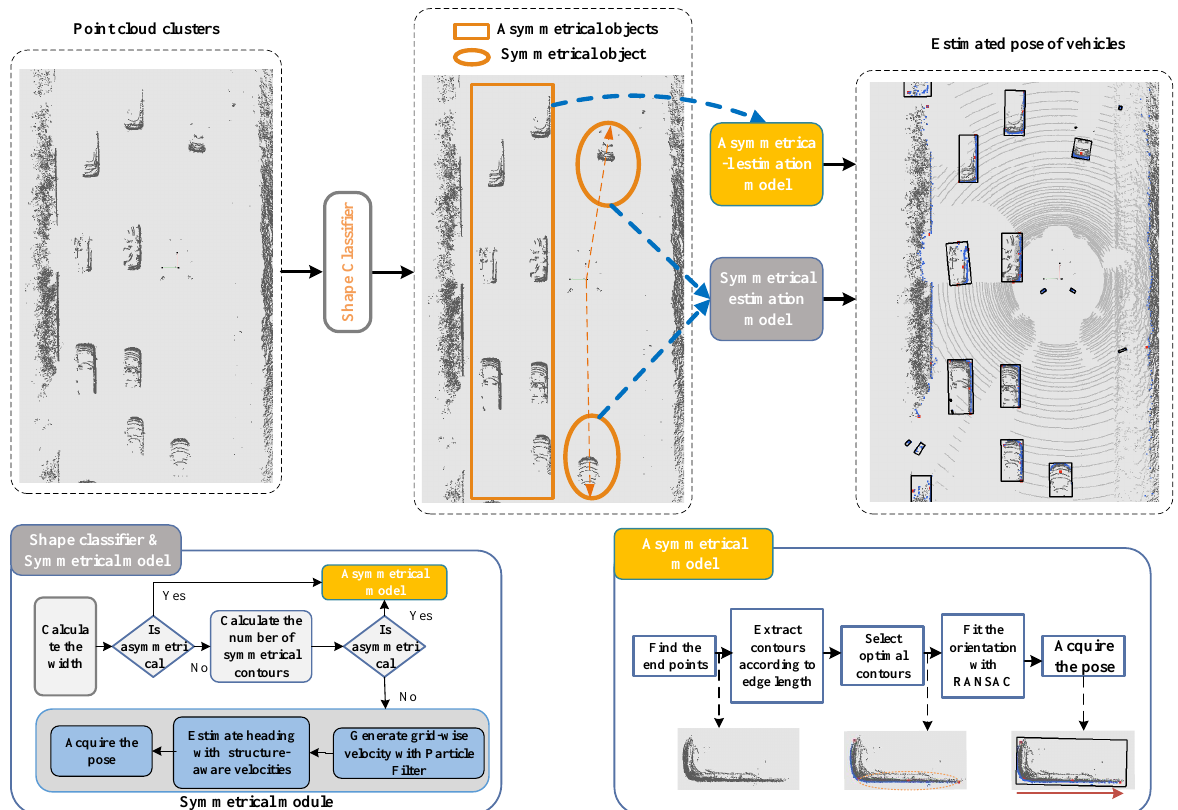
Figure 2. Schematic illustration of PE-HL-PF . It mainly has three components: contour-based geo- metric shape classifier, Pose estimation model for Asymmetrical-like targets, and Pose estimation model for Symmetrical-like targets.